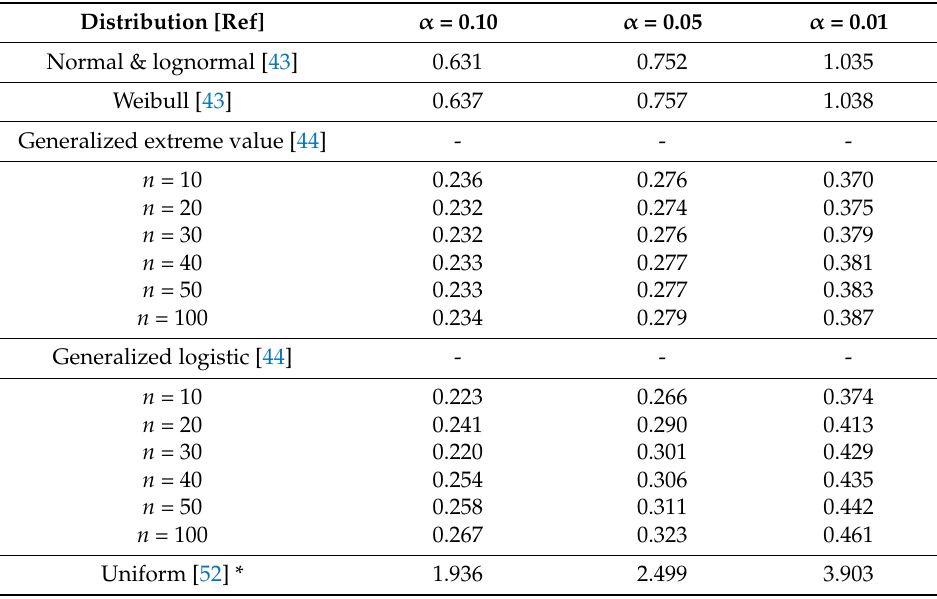
Table 2. Anderson–Darling test: critical values according to significance level.